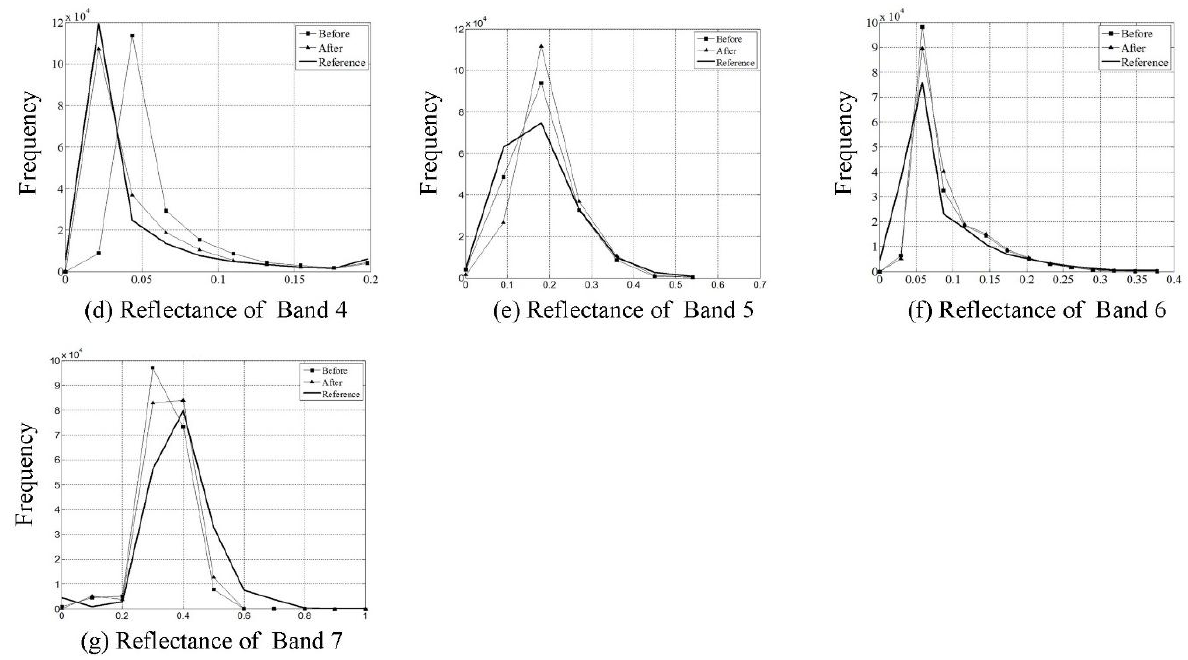
Figure 7. Histograms of reflectance values for the cloud-covered pixels in 13 July 2014 image before and after the algorithm, and for the corresponding pixels of the reference image acquired on 29 July 2014. ( a ) Band 1; ( b ) Band 2; ( c ) Band 3; ( d ) Band 4; ( e ) Band 5; ( f ) Band 6; ( g ) Band